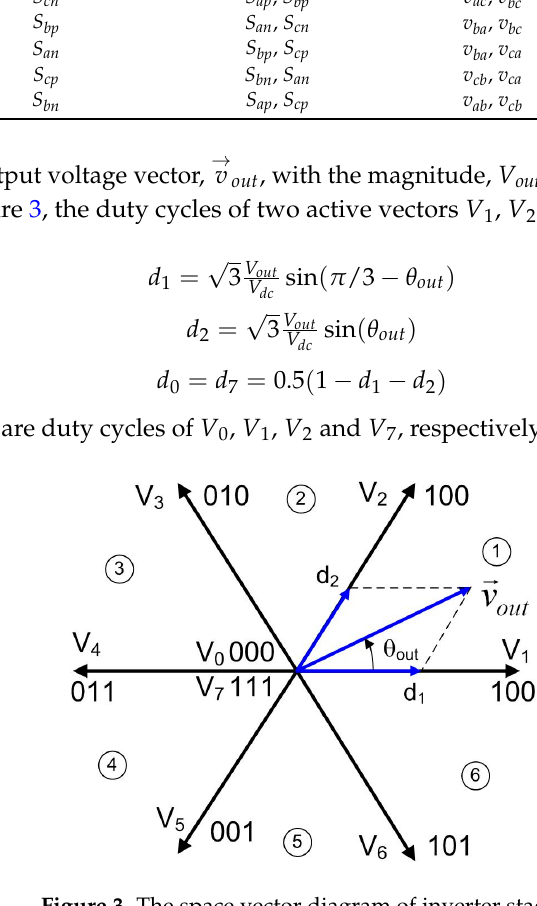
Table 1. The switching states and their DC-link voltages according to the input sector.